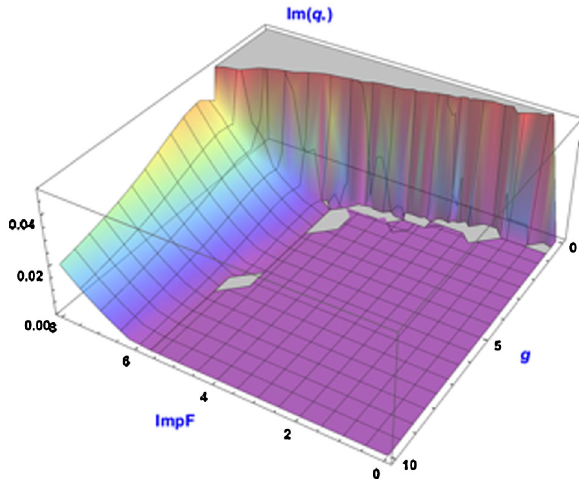
FIG. 23. Growth rate for the resistive feedback and chroma- ticity ξ ¼ − 1